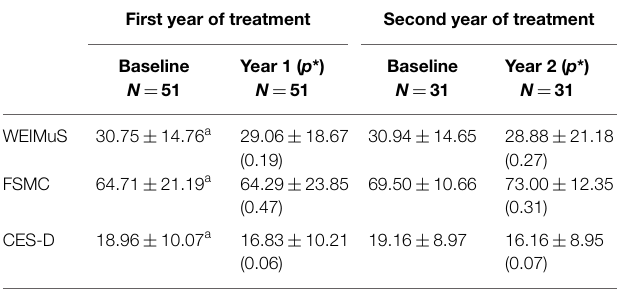
TABLE2 | Changesinfatigueanddepressionoverthetotalsampleandboth years of observation